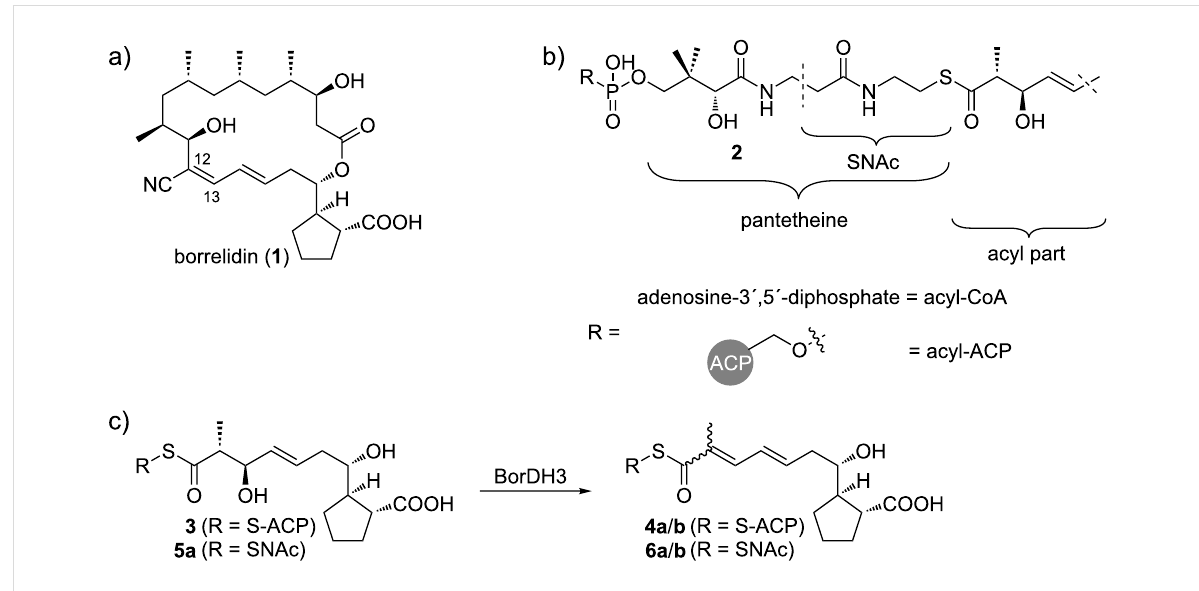
Figure 1: a) Structure of borrelidin ( 1 ); b) PKS intermediates are attached to an acyl carrier protein domain (ACP) via a 4'-phosphopantetheine linker, giving acyl-ACPs ( 2 ); c) BorDH3 catalyzes the dehydration of ACP-bound 3-hydroxyacylate 3 to one of the ACP-bound enoates 4a or 4b . The